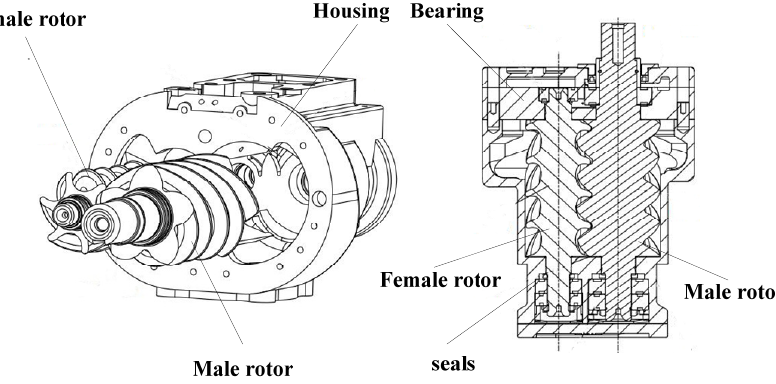
Figure 3. The schematic diagram of the basic structure of screw expander.